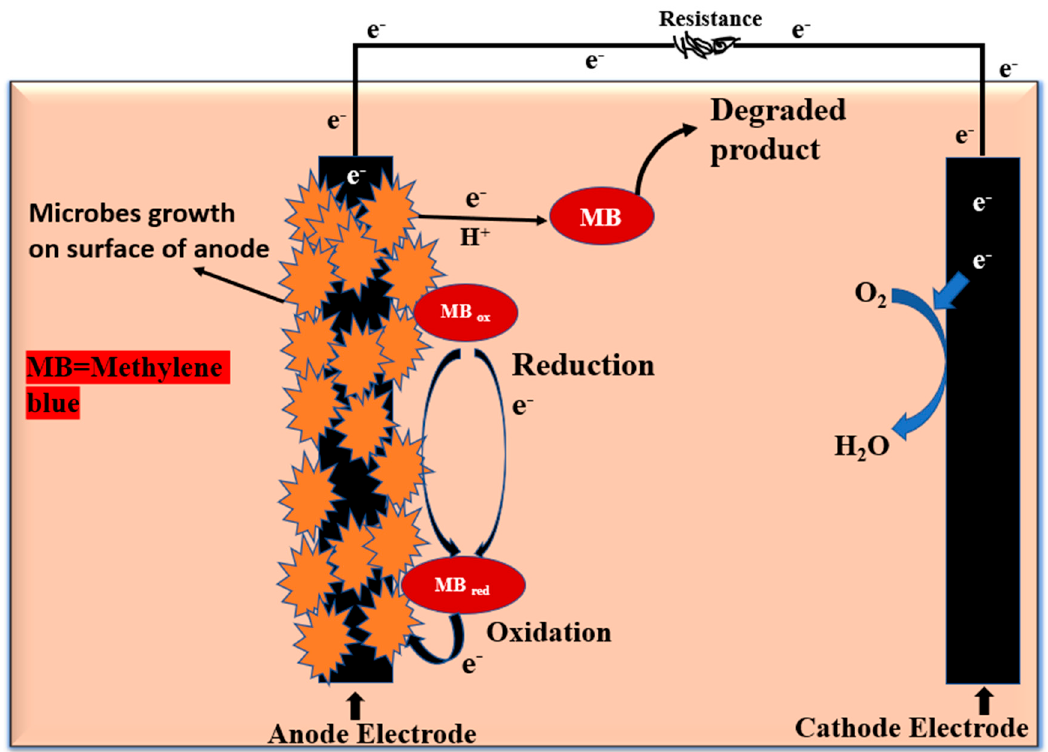
Figure 3. Degradation mechanism of organic dyes through MFCs.